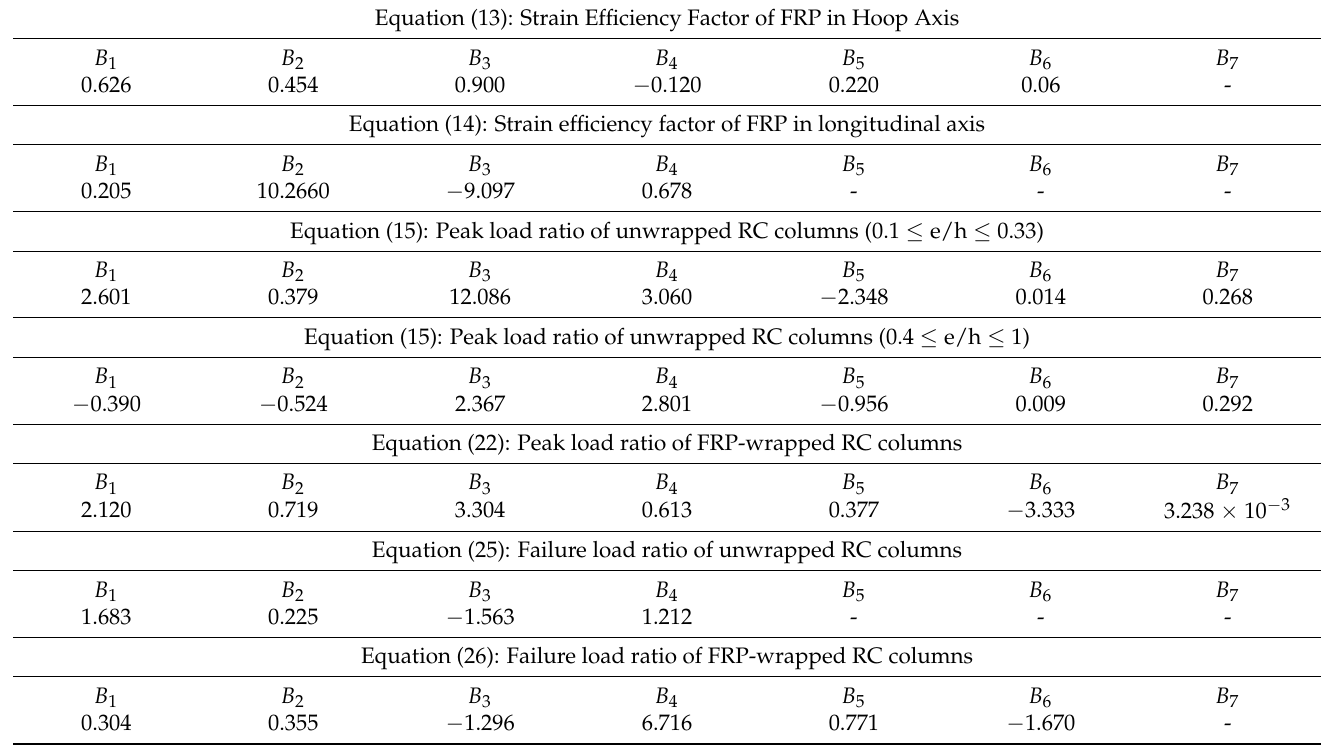
Figure 4. Comparison between experimental and predicted longitudinal FRP strain efficiency factors. Table 4. Regression parameters for the proposed expressions.